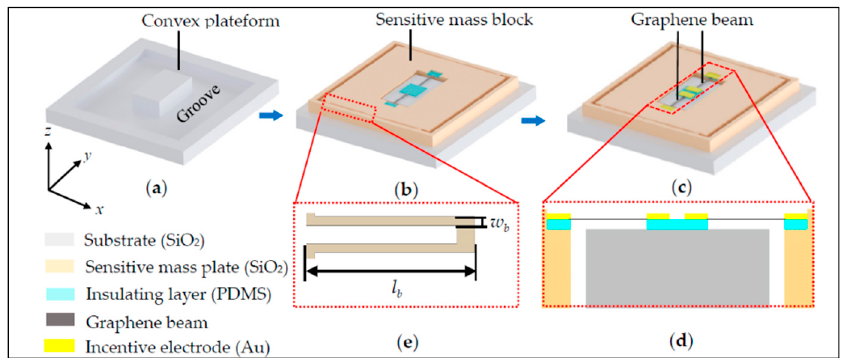
Figure 2. Accelerometer based on suspended cross-type graphene resonator.